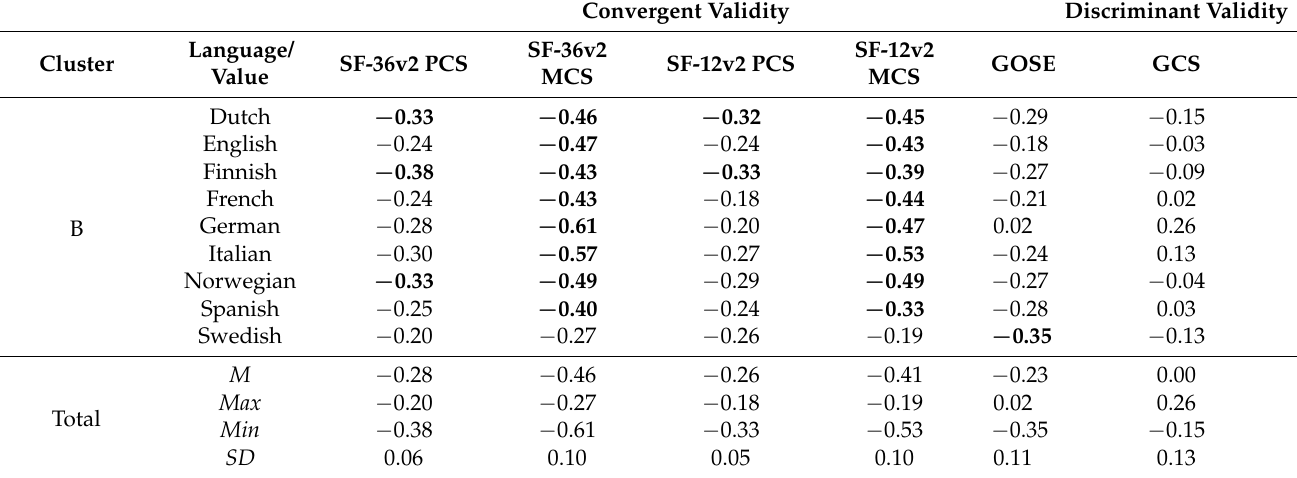
Table A2. Convergent and discriminant validity of the PCL-5